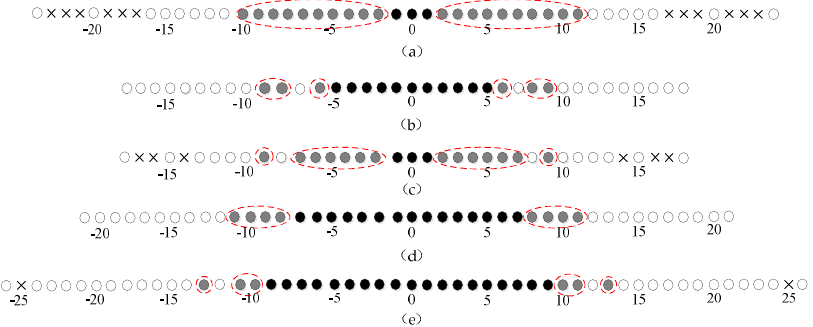
Figure 1. Comparisons of coarray distribution with N = 6 sensors ( a ) NA; ( b ) CPA; ( c ) DsCAMps; ( d ) TNA-I; ( e ) TNA-II, where black circles, white circles, and grey circles are respectively denote DCA, consecutive parts of SCA, and the overlapping sensors, the overlapping virtual sensors are also marked by red dashed circle boxes.